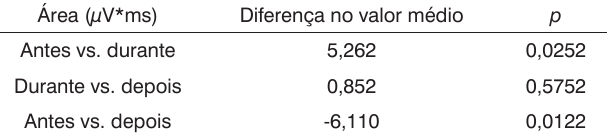
Figura 5. Gráfico box plot da latência nos três momentos experimentais. Tabela 4. Comparação das diferenças na área no teste de Wilcoxon.